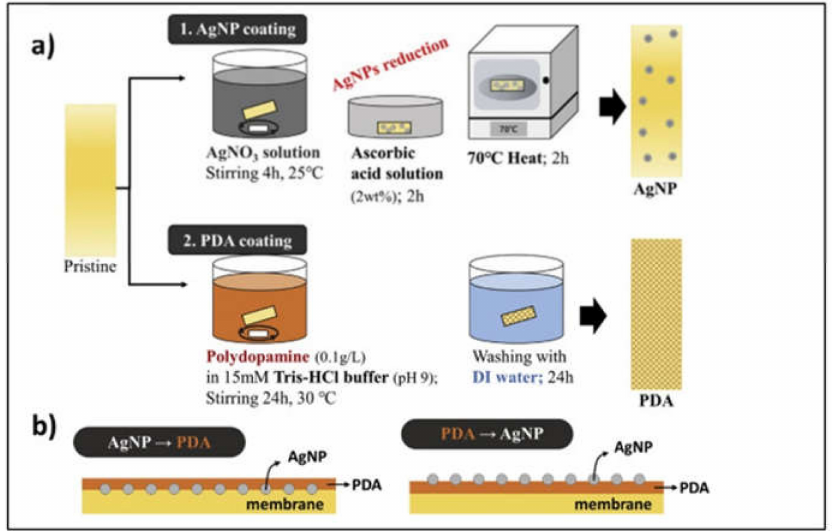
Figure 9. Membrane modification using silver nanoparticles (AgNPs) and polydopamine (PDA). ( a ) Procedures of AgNPs coating and PDA coating on membranes, and ( b ) Schematic comparing PDA coating after AgNP coating and AgNP coating after PDA coating. Reprinted with permission from Ref. [60]. Copyright Elsevier